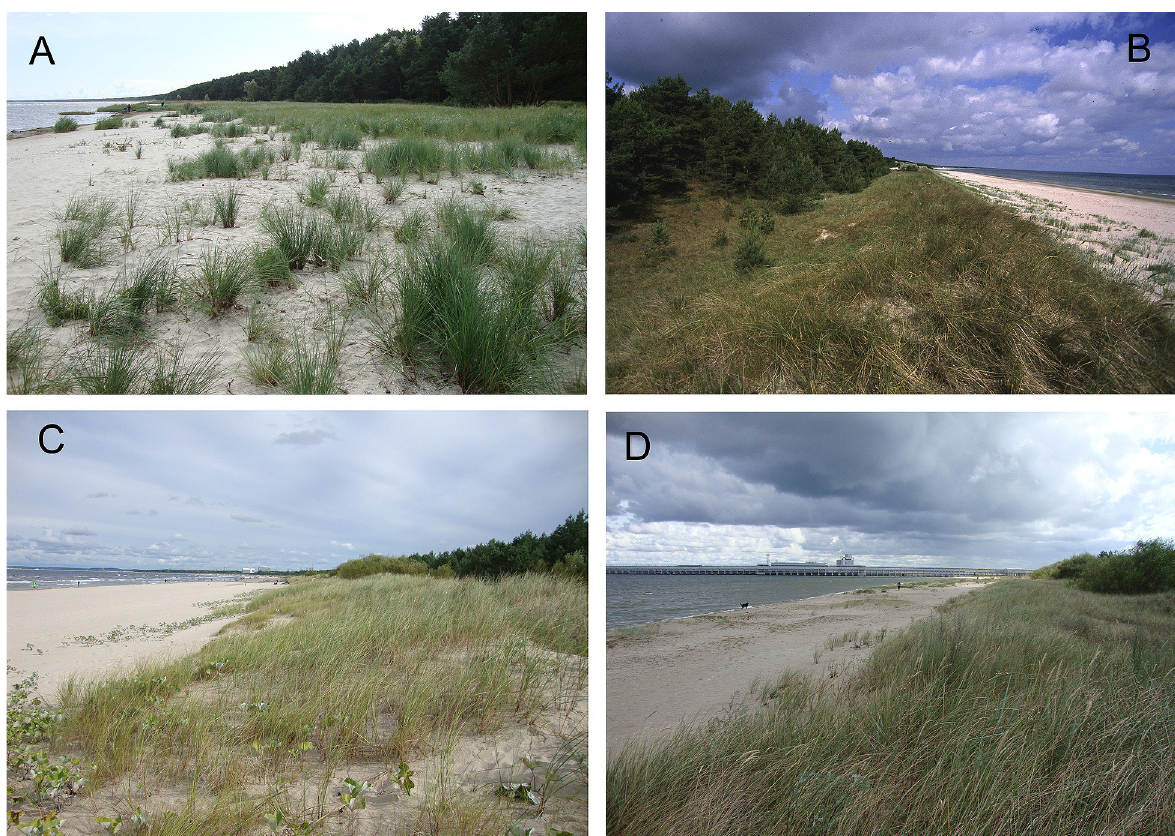
Fig. 4. Usedom and Wolin islands dune coast (Photo T. Łabuz